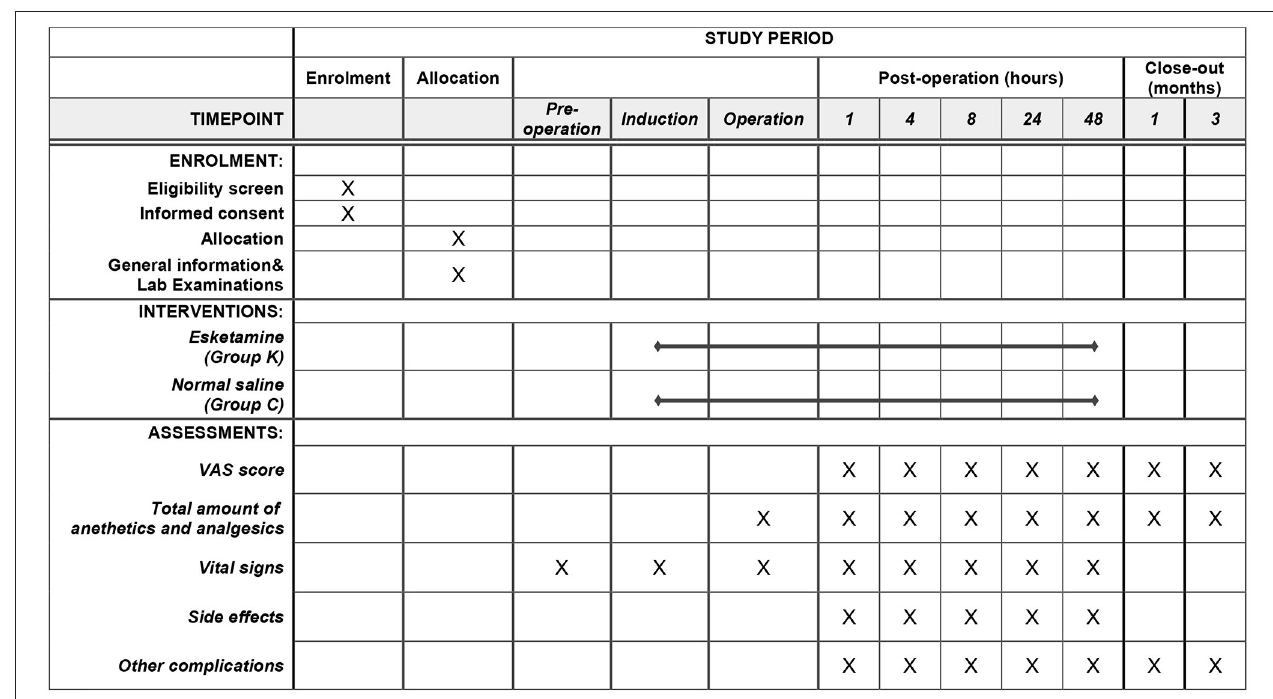
FIGURE 2 | Study timeline and schedule of enrolment, allocation, interventions, and assessments according to SPIRIT 2013